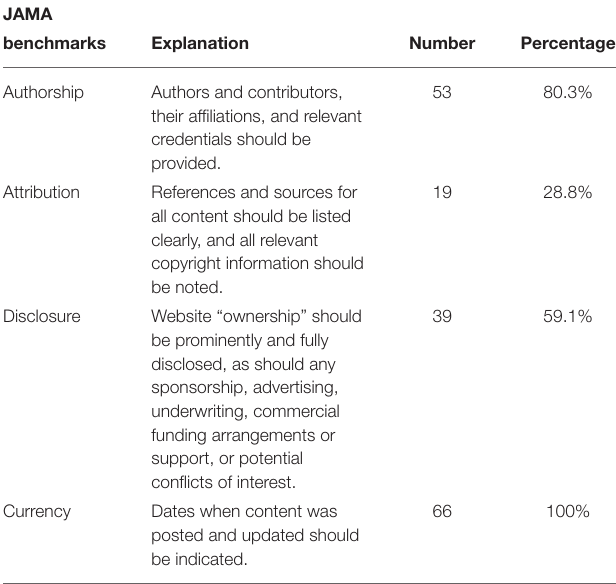
TABLE 3 | JAMA benchmarks, number, and percentage of YouTube